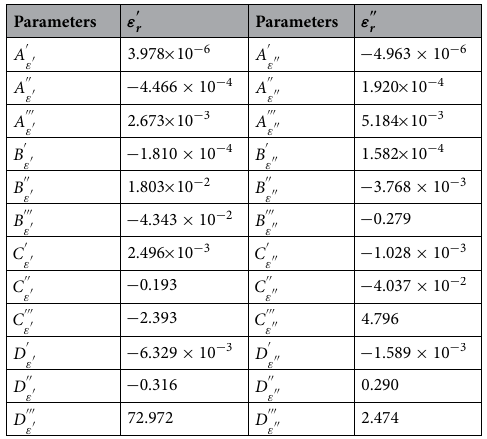
′ ′′ r ) and the imaginary ( ε r ) parts of the relative permittivity according